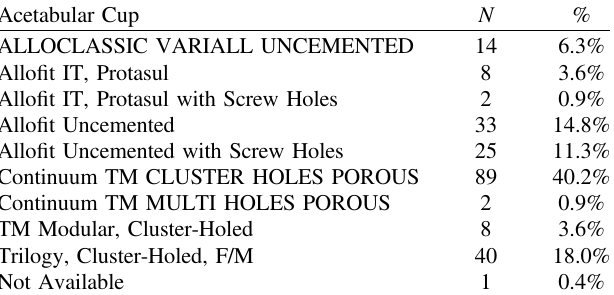
Table A.2. Acetabular cup used.